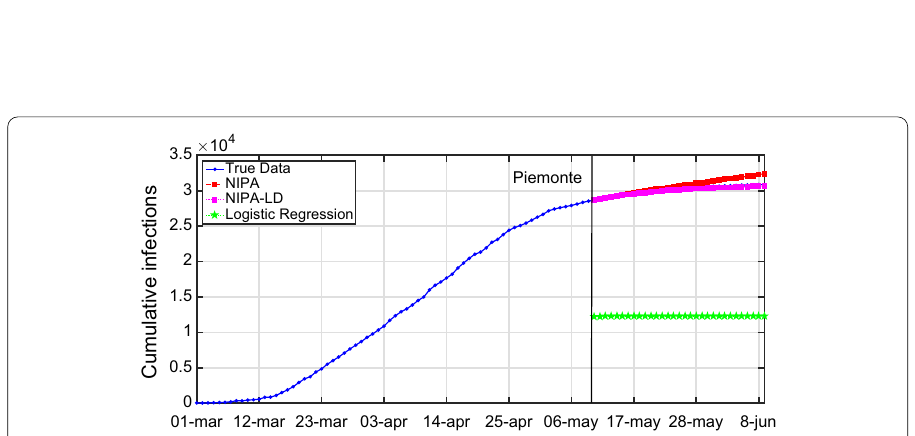
Fig. 3 Cumulative infections for